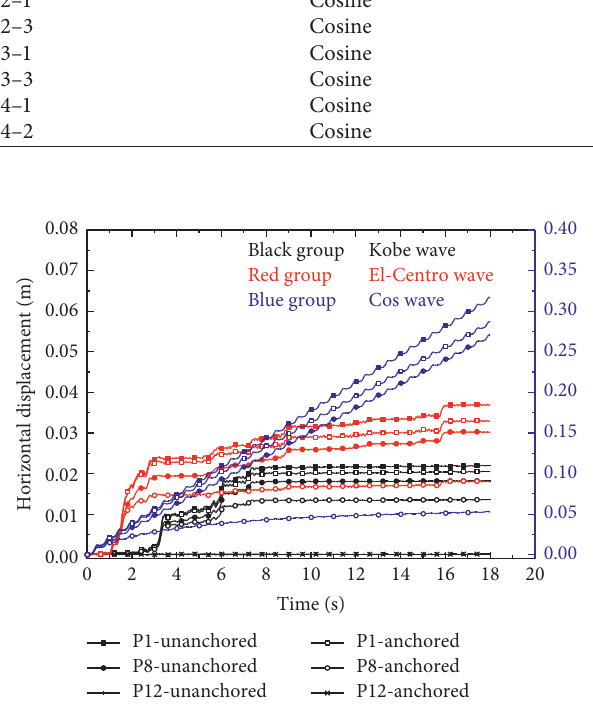
Figure 4: Relative displacement of slope with different seismic